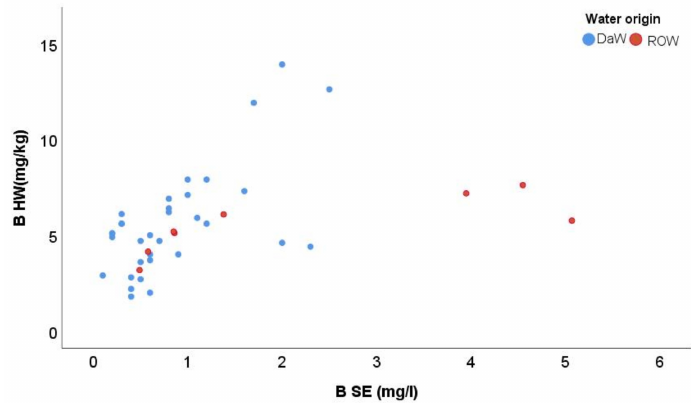
Figure 2. HWSB, in mg / kg, vs. B content in Saturation Extract (BSE, in mg / L) in Gran Canaria, depending on the water quality applied: DaW and